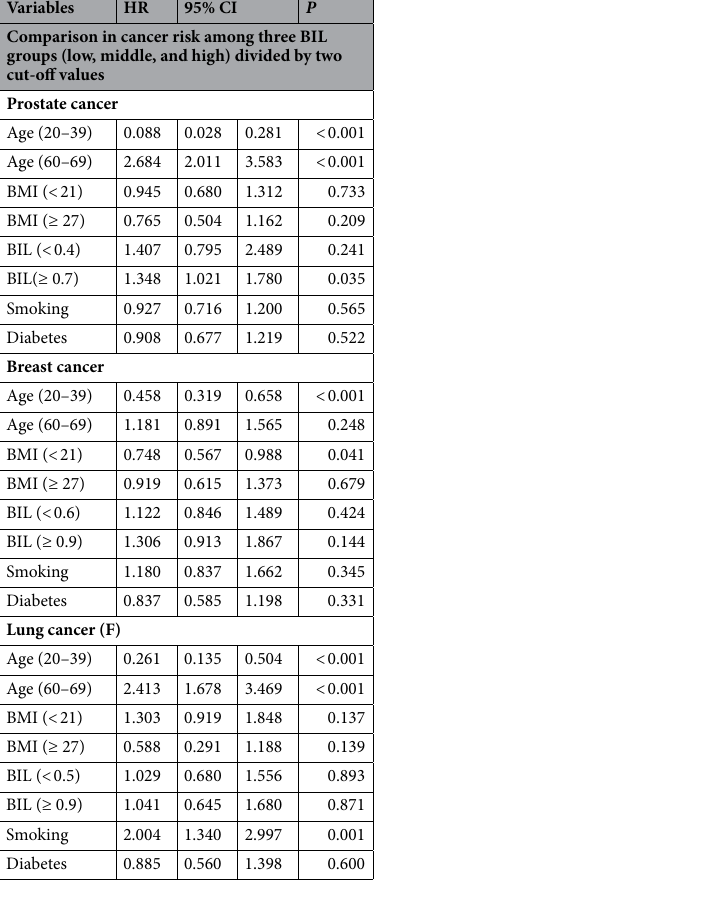
statistically significant.